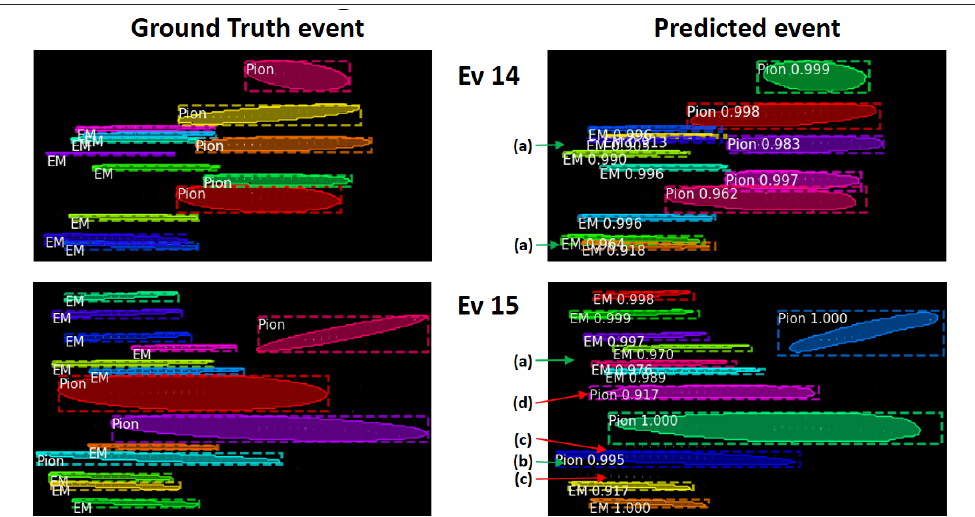
Figure 5. Two event predictions are shown here: (top) one among the best predictions, (bottom) one among the worst predictions. These 2 predictions have been taken from the validation set. The Ground Truth events (EM / Pion classes, cluster bounding box, and the ellipse mask of the cluster) are displayed on the left whereas the predicted clusters (EM / Pion class, bounding box, and mask) are displayed on the right. The probabilities / scores of the prediction are written above the clusters / showers in the right images. Legend: (a) arrows shows the capability to predict dense regions of clusters; (b) the model makes good prediction for hadronic showers which start in the Electromagnetic part of HGCAL detector; (c) the model misses an EM cluster; (d) underestimation of the bounding box and mask of an hadronic